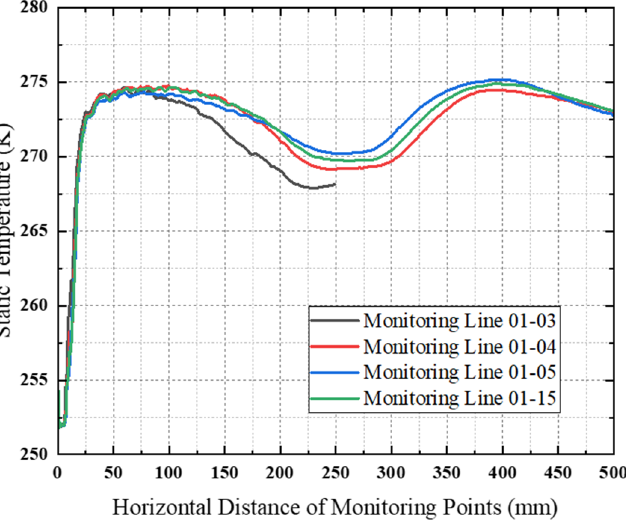
Figure 13. Standard nozzle flow field compressed air pressure 212,782 Pa, temperature 303 K static temperature detection line